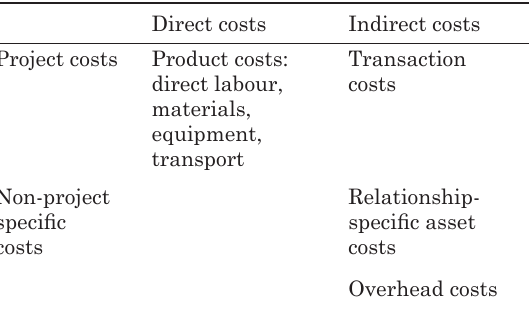
Table 1. Classification of maintenance direct